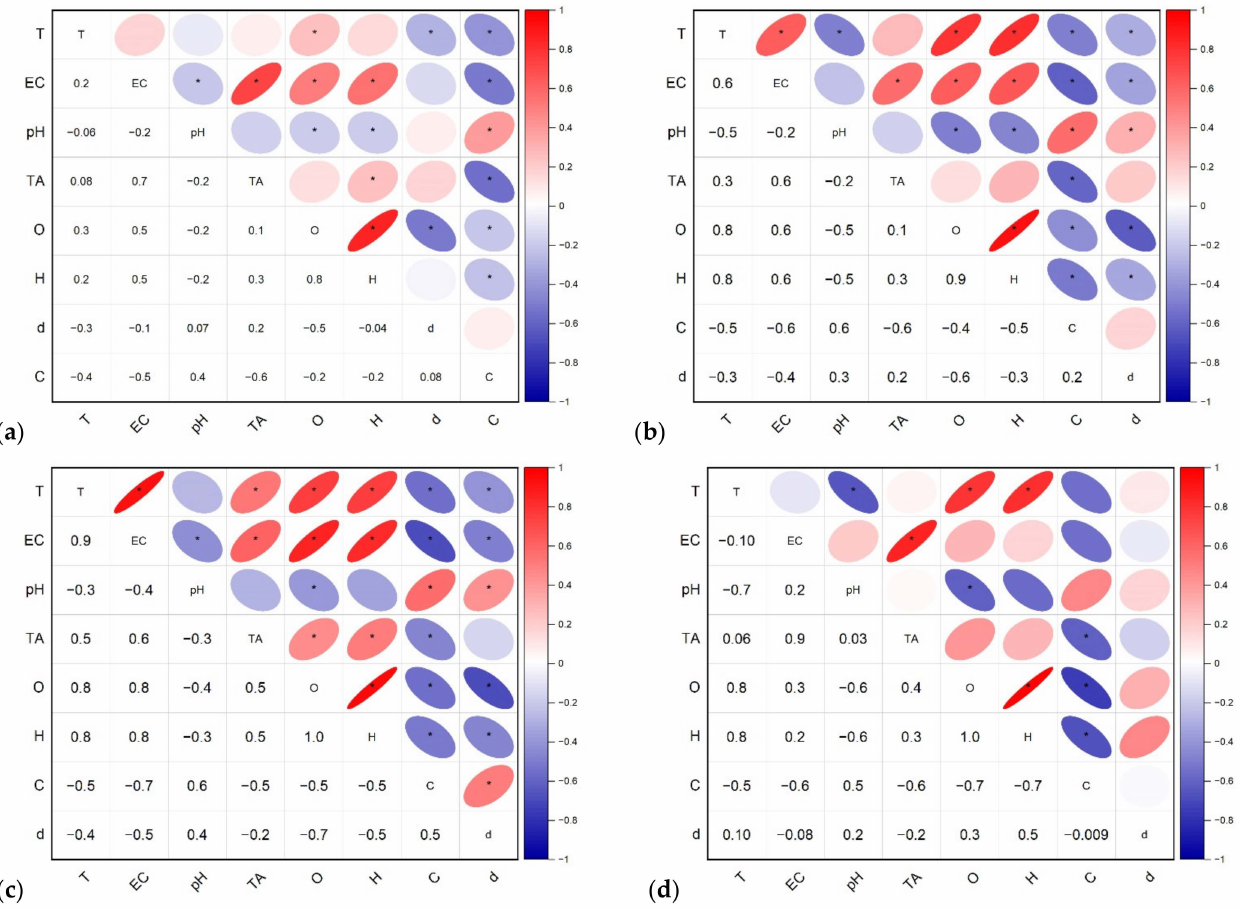
Figure 4. Spearman correlation matrix between determined parameters and ( a ) the whole urban water supply system (N = 104); wells at ( b ) Ljubljansko barje and Ljubljansko polje (N = 41); ( c ) Ljubljansko polje (N = 30); ( d ) Ljubljansko barje (N = 11). * p ≤ 0.05. H, O and C represent δ 2 H, δ 18 O and δ 13 C DIC , respectively.